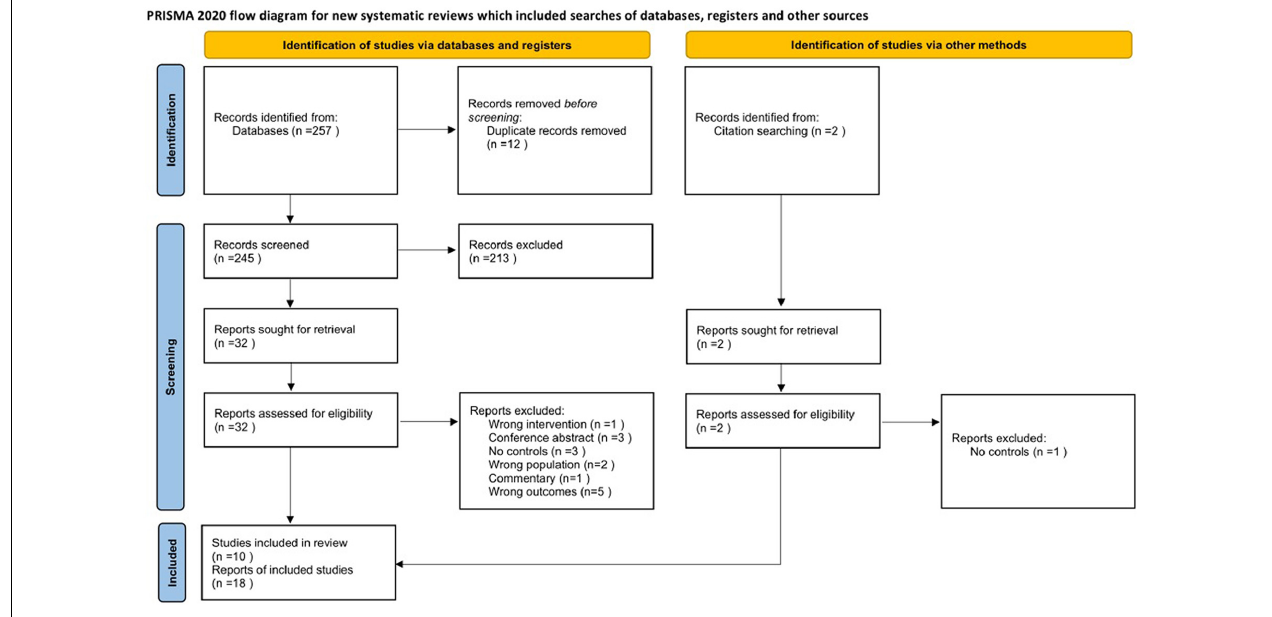
FIGURE 1 | Flow diagram of the study selection